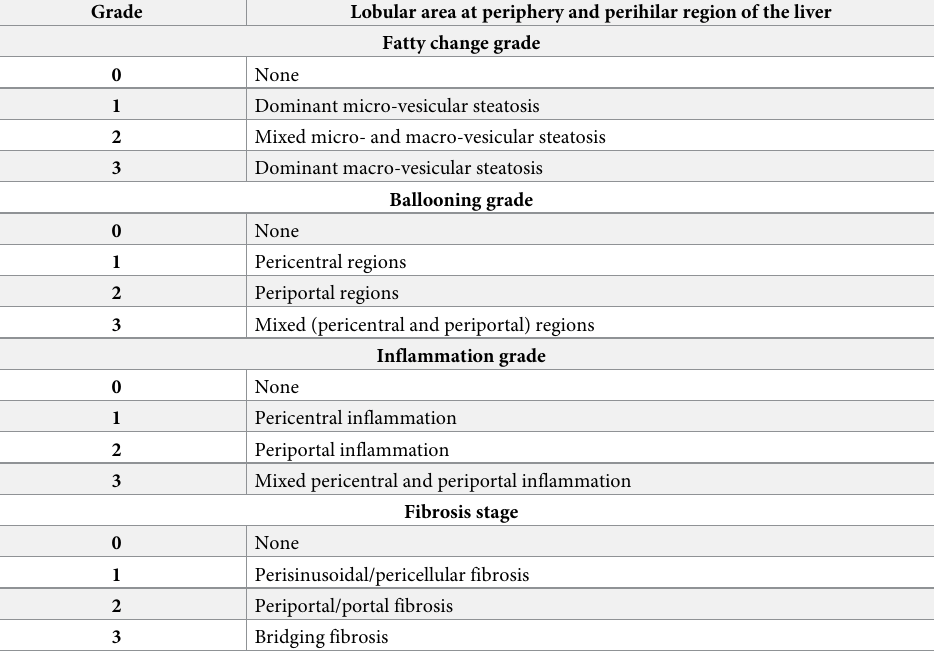
Table 2. The histological scoring system of hepatic lobules in NAFLD modified from [11, 31, 32]. Grade Lobular area at periphery and perihilar region of the liver Fatty change grade 0 None 1 Dominant micro-vesicular steatosis 2 Mixed micro- and macro-vesicular steatosis 3 Dominant macro-vesicular steatosis Ballooning grade 0 None 1 Pericentral regions 2 Periportal regions 3 Mixed (pericentral and periportal) regions Inflammation grade 0 None 1 Pericentral inflammation 2 Periportal inflammation 3 Mixed pericentral and periportal inflammation Fibrosis stage 0 None 1 Perisinusoidal/pericellular fibrosis 2 Periportal/portal fibrosis 3 Bridging